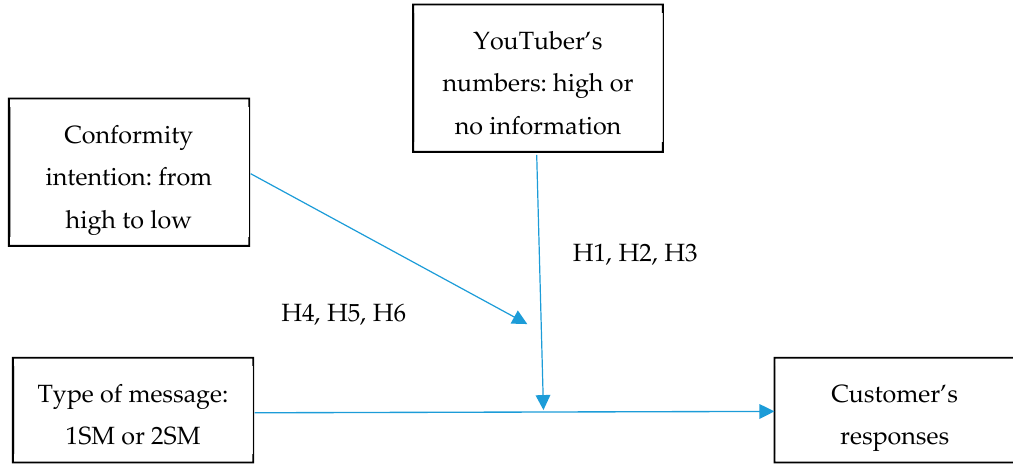
Figure 1. Proposed theoretical model for the interaction effect of type of message X YouTuber’s media metrics and the moderation of conformity intention.